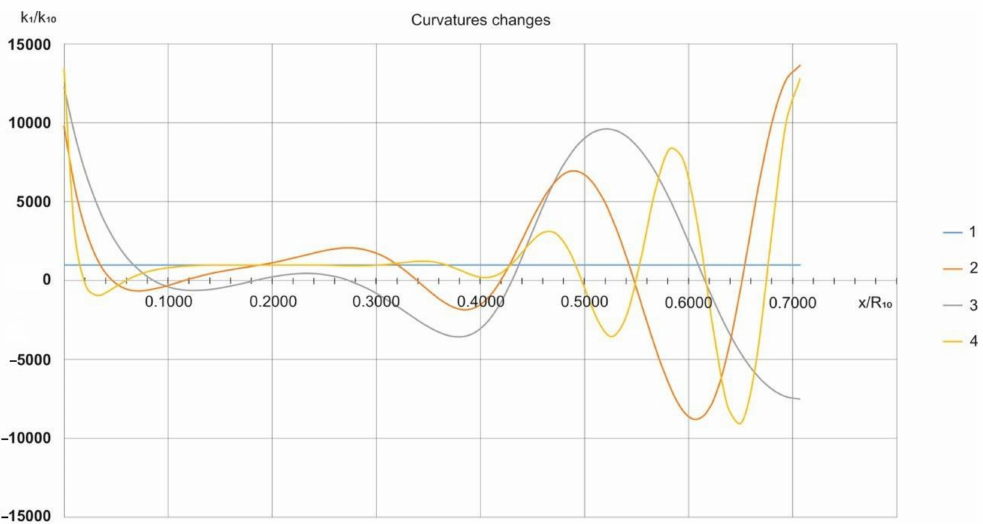
Figure 6. Change in k 1 /k 10 curvatures at p q = 2.36 for the considered variants of isotropic and orthotropic